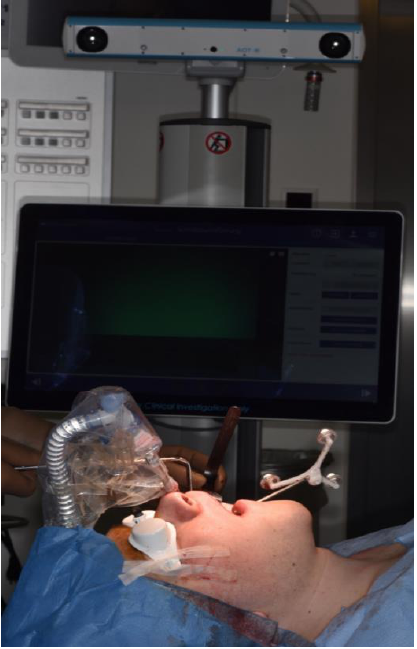
Figure 3. Intraoperative position of the CARLO® navigation system on the left side of the patient with the navigation marker attached to the hard palate using two 11.0-mm self-drilling intermaxillary fixation (IMF) screws. The white goggles provide ocular protection during laser cutting. The graphical user interface on the left side of the patient provides real-time visual information about the operating area obtained by a camera embedded in the laser head and about the bone thickness in the form of a histogram. Auditory feedback informs the surgeon when the osteotomy is completed.